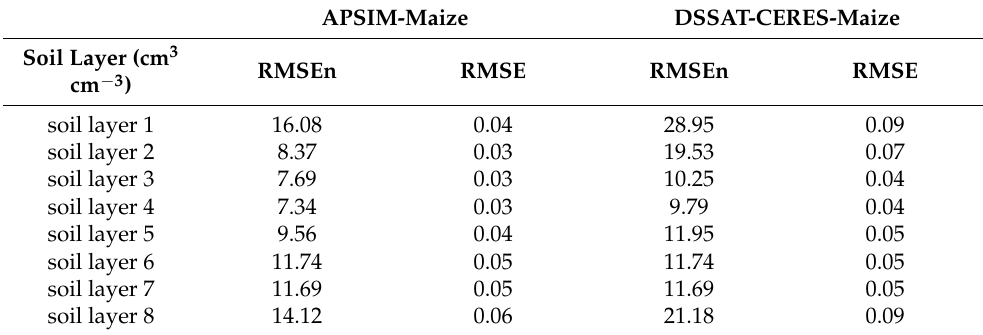
Table 13. The APSIM-Maize and DSSAT-CERES-Maize model calibration statistics for the root soil water content under rainfed